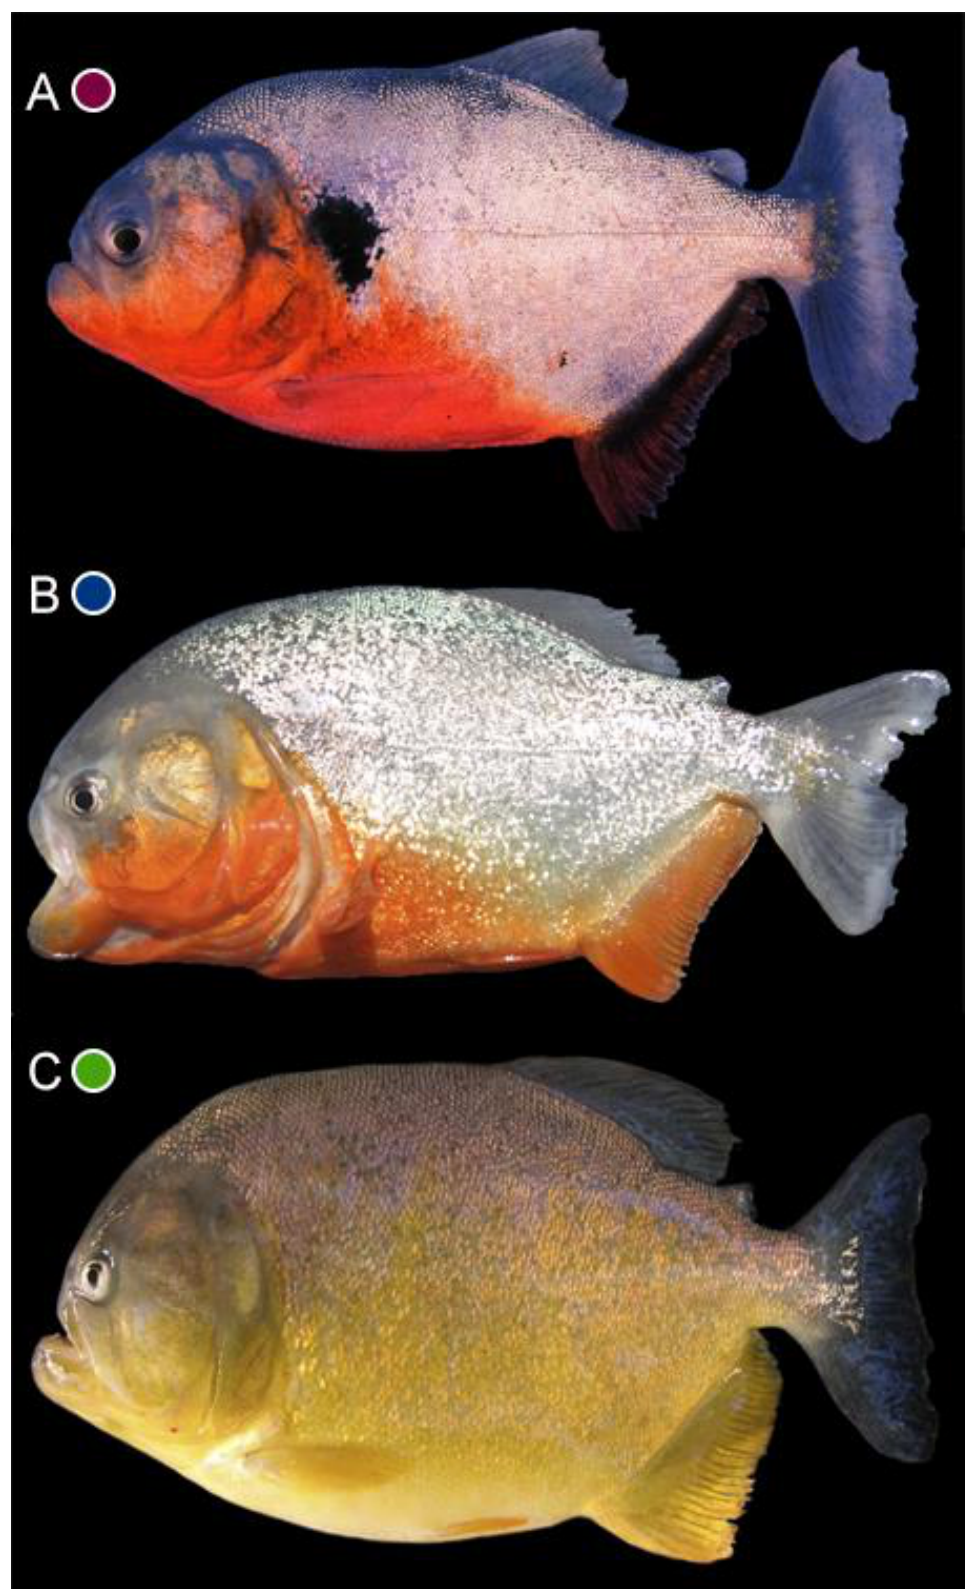
Figure 1. Representative specimens of Pygocentrus : ( A ) P. cariba , Río Apure, LBP 10225. ( B ) P. nattereri , Rio das Mortes, Araguaia basin. ( C ) P. piraya , Rio São Francisco. Photographs by Alec Zeinad ( B , C ), specimens not preserved.